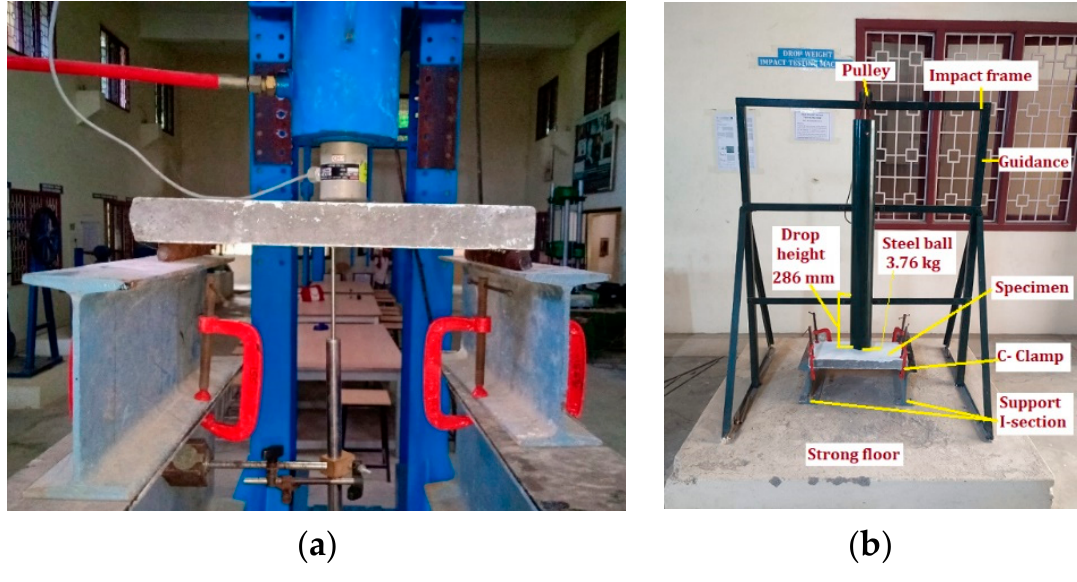
Figure 4. Test setup ( a ) flexure and ( b ) impact.